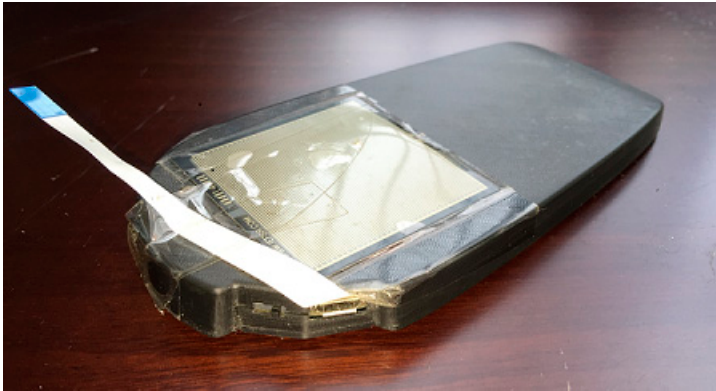
Figure 11. The insole-shaped MIMU (Multiple Inertial Measurement Unit) module.